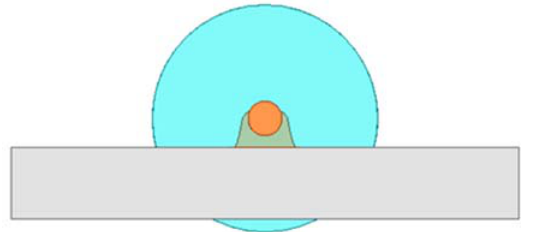
Figure 4. Cross section of the lead wire interconnection.